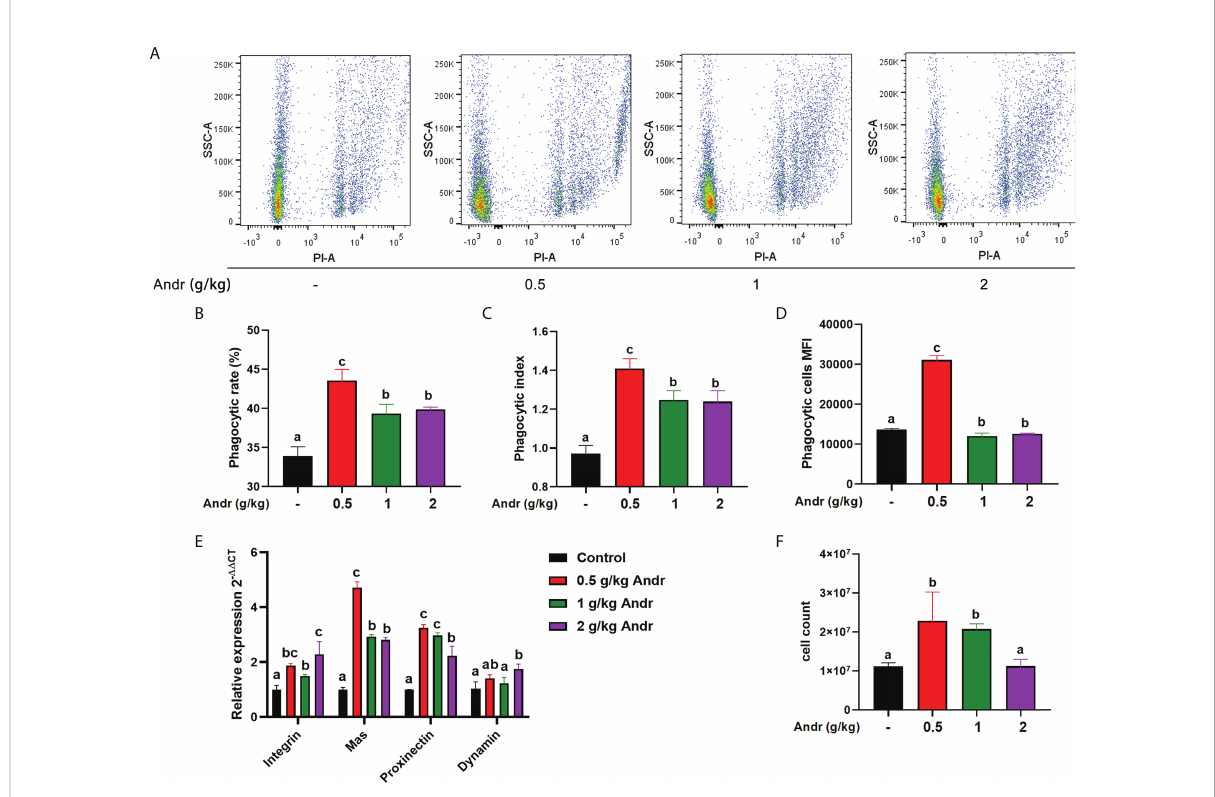
FIGURE 2 Effect of Andr on hemocytes phagocytic function of L. vannamei . (A) Scatter plot of phagocytic hemocytes ingested 0.5 µm microspheres. (B – D) The phagocytic rate, phagocytic index and phagocytic cells MFI in hemocytes. (E) The expression of phagocytic related genes in hemocytes detected by qPCR. (F) Total hemocytes count (THC) of L. vannamei fed a diet containing Andr for 28 days. Values are means ± SD. a,b,c Value bars not sharing the same superscript letter are signi fi cantly different as evaluated by Duncan ‘ s test ( p < 0.05).